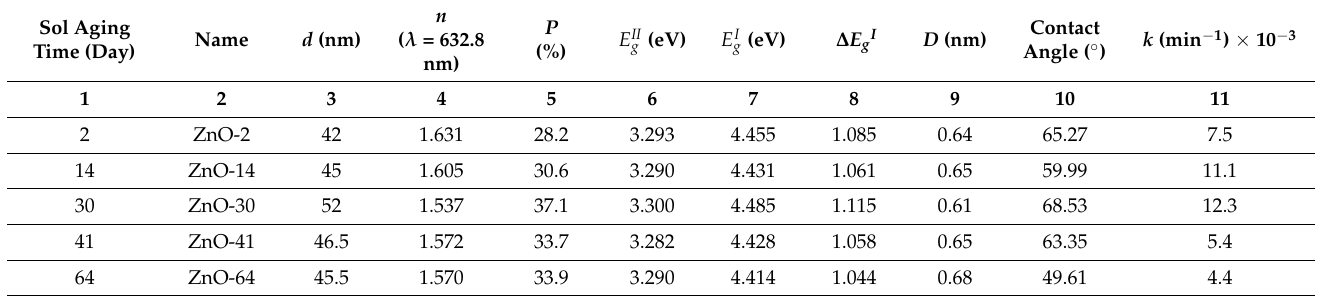
Table 1. Parameters of the films corresponding to different sol aging times ( d —thickness of layers; n —refractive index of layers; P —porosity; E gII —second of the energy band gap; E gI —first of the energy band gap; ∆ E gI = E gI − E gbulk ; D —diameter of nanocrystals; k —degradation rate).